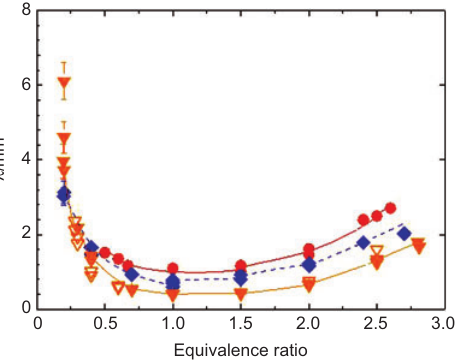
Figure 8 Correlation between the mean detonation cell width and the composition of ethane/O . 2